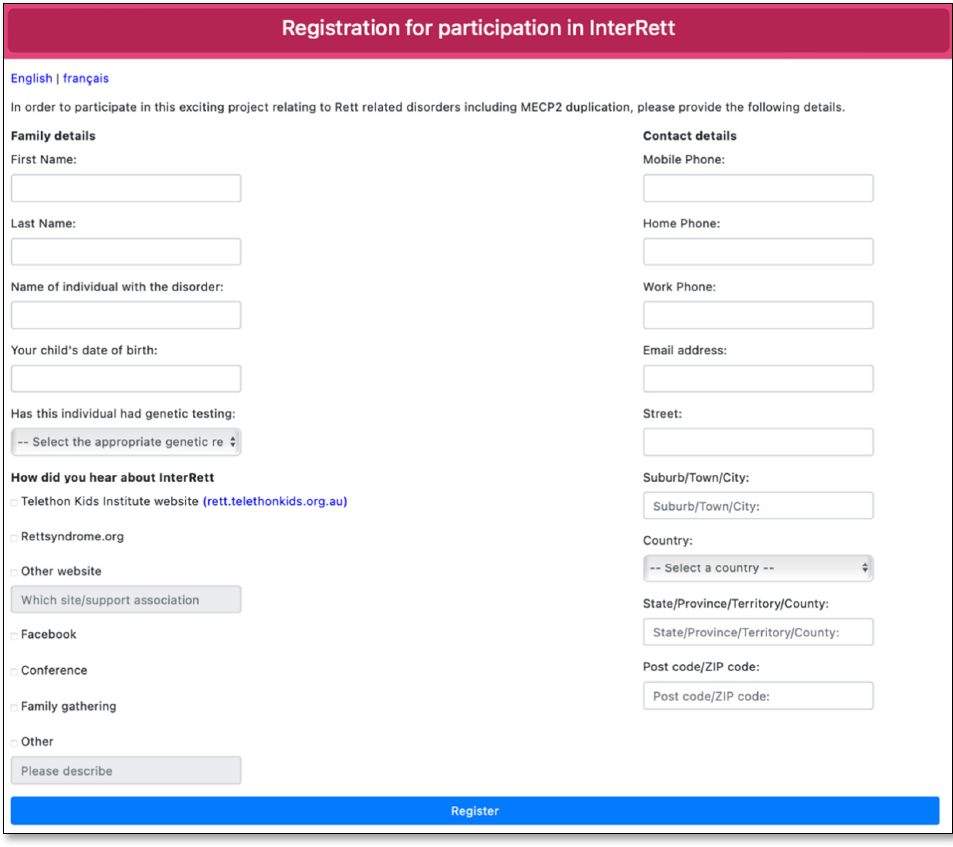
Figure 2. Registration page for the International MECP2 Duplication Database (MDBase).